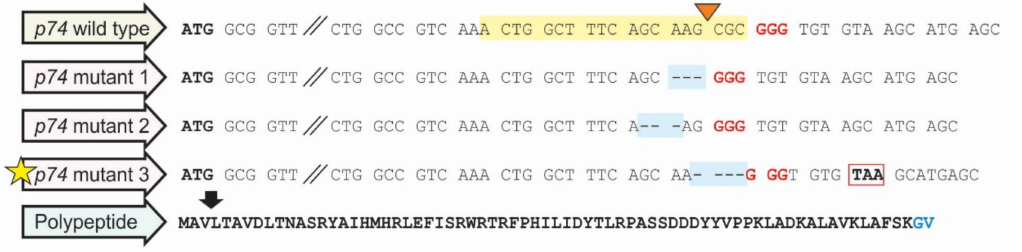
Figure 3. AcMNPV knockout in p74 gene. Sequence result of the p74 -knockout AcMNPV-bacmid. The cRNA recognition site is highlighted in yellow, and the protospacer-adjacent motif (PAM) sequence is indicated in red. The dotted line shaded in light blue corresponds to the nucleotide deletion observed. The red box marks the early stop codon generated by the mutation, and the amino acids in blue are substitutions also resulting from the 4 bp deletion. Both initial and stop codons are in bold. The orange triangle shows where the DSB is expected to be generated. Mutant 3 was selected (highlighted with a yellow